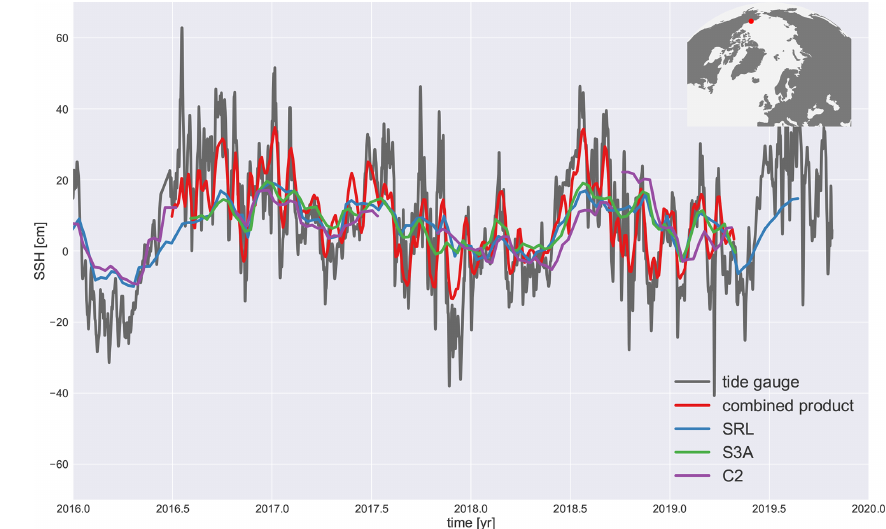
Figure 9. Sea level anomaly time series at station Prudhoe Bay from the tide gauge station (dark gray), the combined altimetry product (red) and mono-mission sea levels for SRL (blue), S3A (green) and C2 (purple). SSH signifies sea surface height.